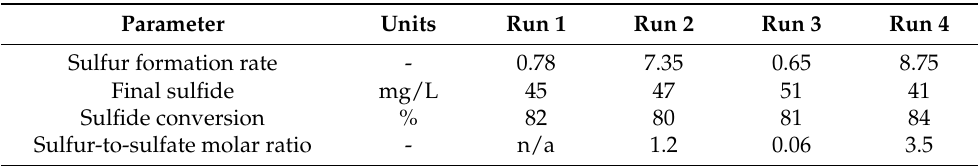
Table 4. Experimental results for the immobilized cells